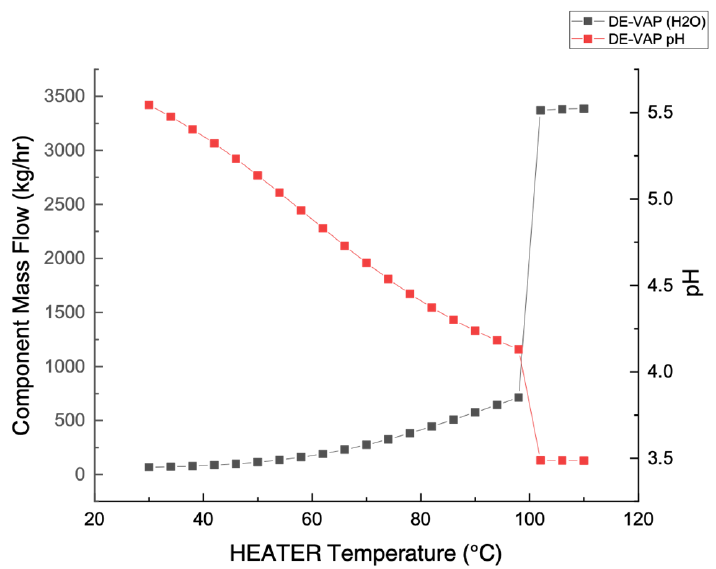
Figure 4. Water vapor mass flow and DE-VAP stream pH as a function of HEATER temperature.